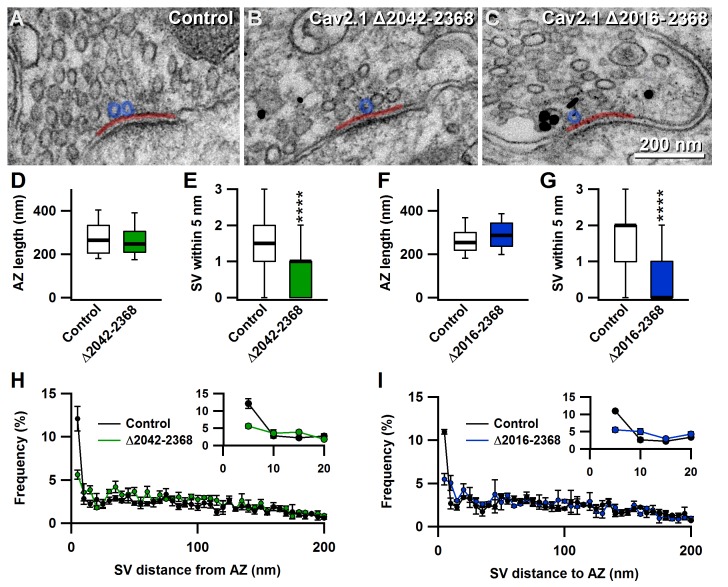
The novel C-terminal region between amino acids 2042 and 2061 regulates the number of docked synaptic vesicles at the active zones.(A–C) Representative EM images showing AZs from nontransduced calyces (A), and calyces transduced with Δ2042–2368 (B) or Δ2016–2368 (C). Transduced cells were identified by pre-embedded nanogold immunolabelling for eGFP (black dots in B and C). (D–G) Quantification of mean AZ length and docked SVs (within 5 nm of the membrane) of calyces transduced with Δ2042–2368 (n = 120; D E) or Δ2016–2368 (n = 100; F G), compared to AZs from the nontransduced contralateral MNTB, respectively. (H–I) Quantification of the mean distribution of SVs up to 200 nm distant from AZs for calyces expressing Δ2042–2368 (n = 120; H) or Δ2016–2368 (n = 100; I). Insets show SVs in closest proximity to the membrane (up to 20 nm). All data are depicted as mean ± SEM.